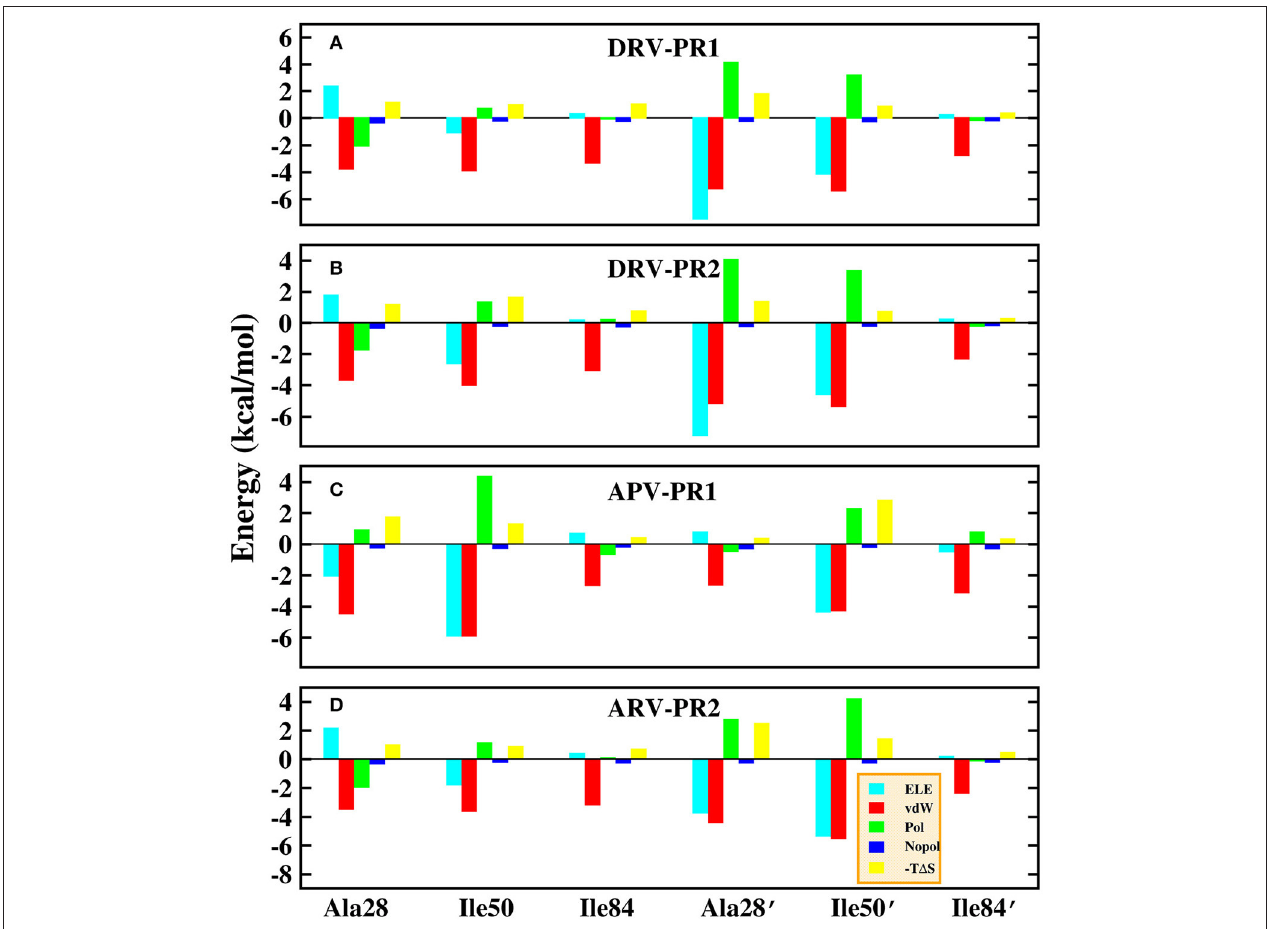
FIGURE 14 | Decomposition of the binding free energy on a per-basis into contributions from electrostatic interaction (ELE), van der Waals interaction (vdW), polar solvation energy (Pol), non-polar solvation energy (Nopol), and entropy change (-T 1 S) in the six hot-spot residues. (A) DRV-PR1 complexes. (B) DRV-PR2 complexes.